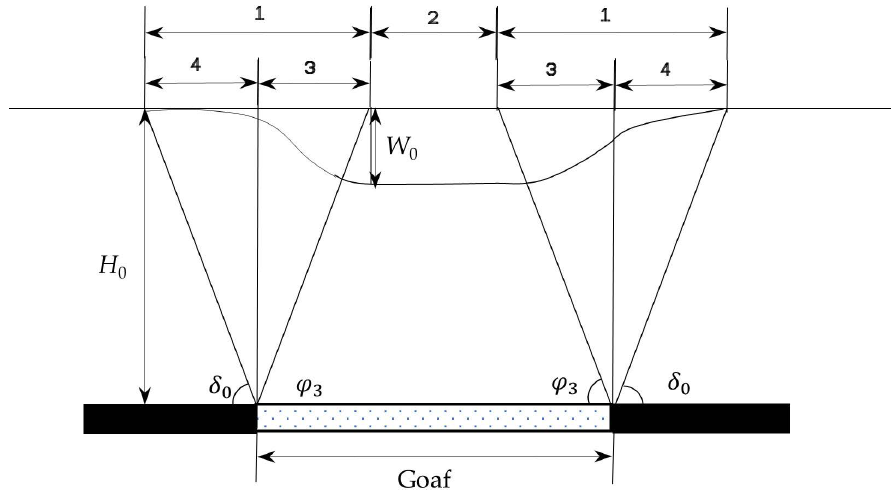
Figure 4. Section of the subsidence basin. W 0 —maximum sinking value; H 0 —average mining height; δ 0 —boundary angle; ϕ 3 —full mining angle; 1—move the deformation zone; 2—uniform subsidence area; 3—compression deformation zone; 4—stretch deformation zone.